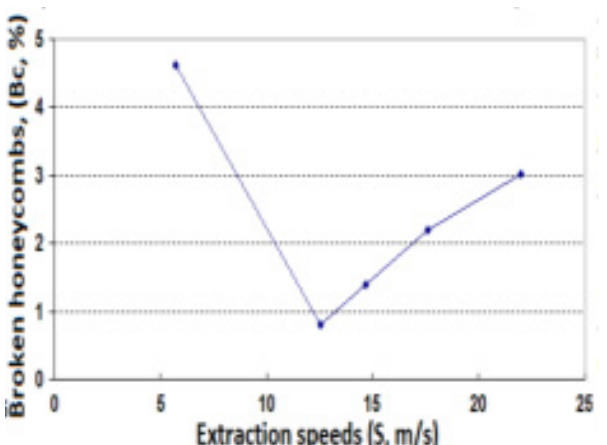
Figure 14. Relationship between speed of honey harvester and damage to bee frame [25].